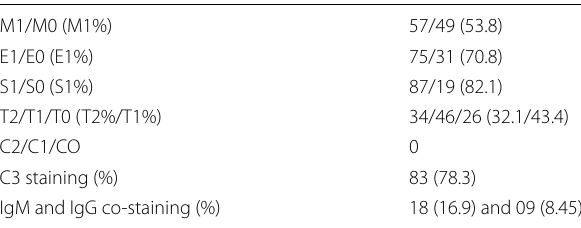
Table 2 Histopathological parameters at baseline.